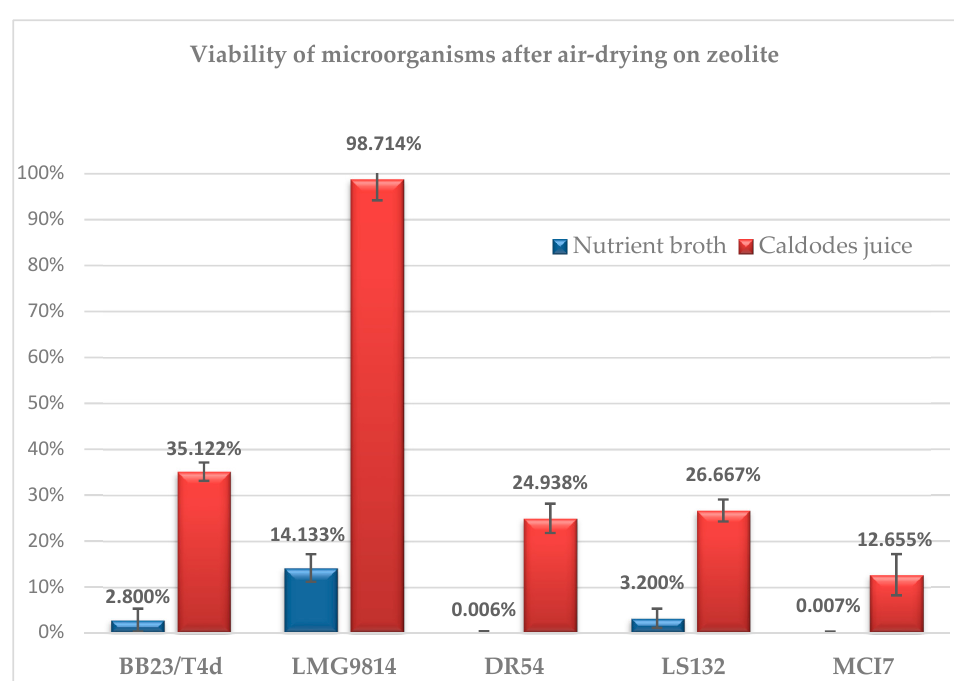
The cell survival rate of A. chroococcum LS132 and R. aquatilis BB23/T4d ranged from 2.69% to 35.12%.